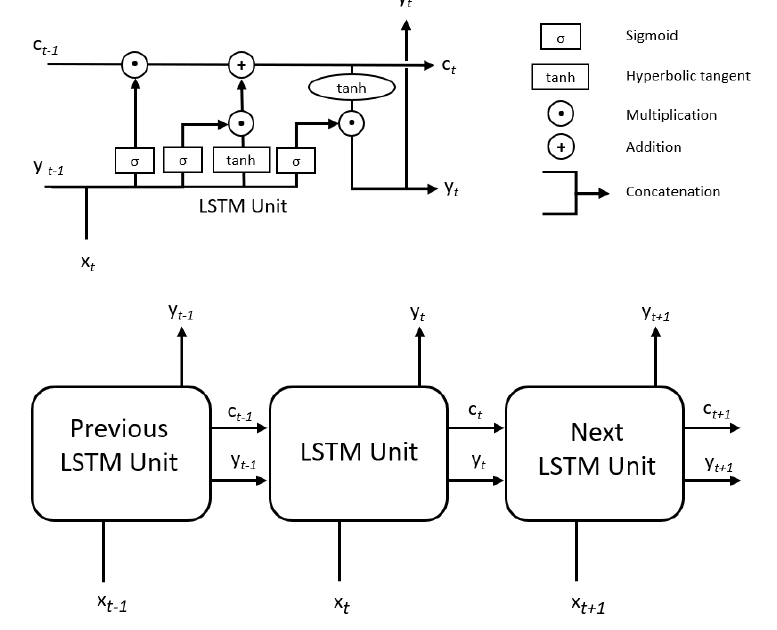
Figure 2. LSTM Univariate. The single input is the value to predict. The output obtained (y t ) and the cell state (c t ) for each LSTM unit is the input (x t ) of the next unit.